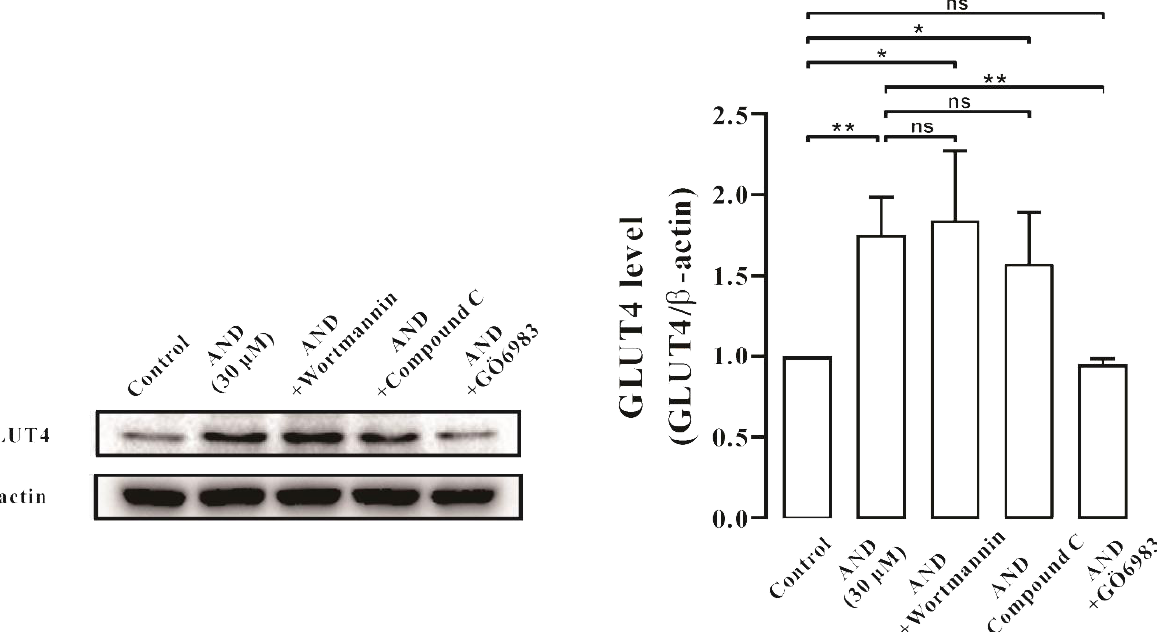
Figure 7. AND induced GLUT4 expression through the PKC signaling pathway. The control group was considered as 1 for data analysis. The expression of GLUT4 induced by AND under the action of three inhibitors. ns: p >0.05; *: p <0.05; **: p <0.01.